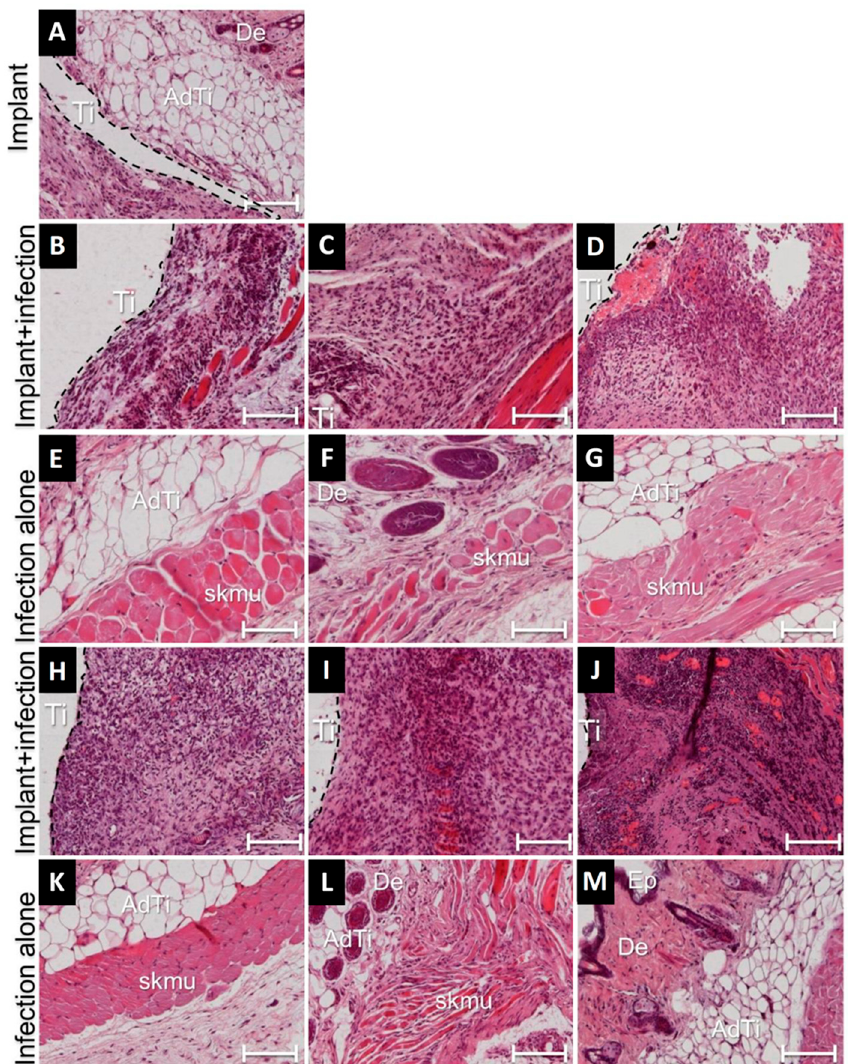
Figure 4. Histological evaluation around sterile and infected implants as well as in areas of infections without implants on day 21. Few immune cells are present at the sterile implant (Ti) tissue interface ( A ). Large numbers of inflammatory cells (blue nuclei) were present at tissues-implant (Ti) interfaces infected with S. oralis ( B ), A. actinomycetemcomitans ( C ), P. gingivalis ( D ) or T. denticola ( H ). Tissue infections without implants showed no signs of inflammation ( E , F , G , K ). Tissue-implant interfaces infected with dual species S. oralis-P. gingivalis ( I ) and A. actinomycetemcomitans-T.denticola ( J ) showed huge recruitment of inflammatory cells (blue nuclei). Dual species infected tissues without implants did not exhibit high recruitment of inflammatory cells ( L , M ). Abbreviations: Ti, site of implantation; AdTi, adipose tissue; skmu, skeletal muscles in the tissue, Ep, epidermis, De, dermis. The dashed border line indicate tissue-implant interface. The scale bar represents 100 micrometers in each